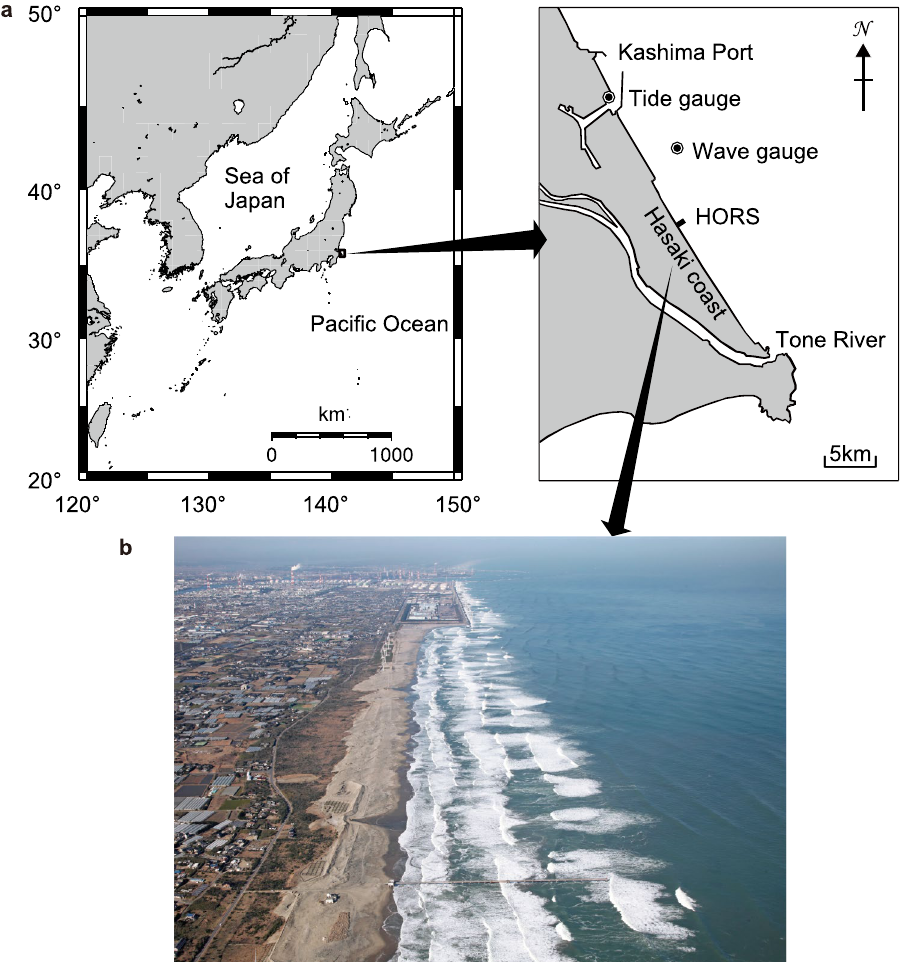
Figure 1. Hasaki coast. ( a ) The locations of the Hasaki coast, showing the locations of the Hazaki Oceanographical Research Station (HORS), the wave gauge and the tidal gauge; ( b ) aerial photo of the coast taken with the HORS pier.